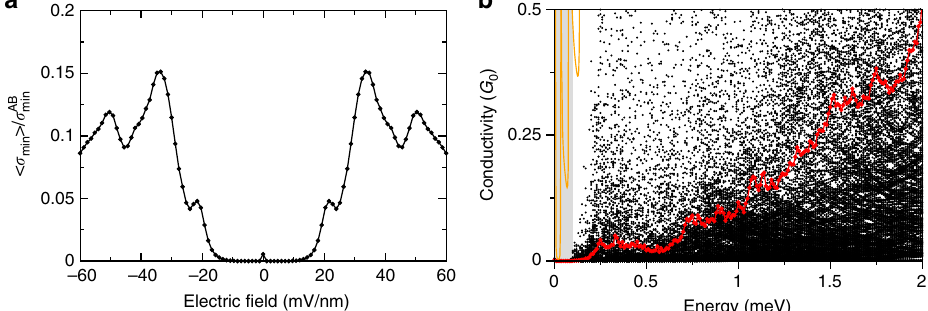
Fig. 5 Restoration of the metallic state. Dependence of the partial dislocation induced insulating state on a layer symmetry breaking potential V and b the Fermi energy E F . In both panels the conductivities are obtained by averaging over a large ensemble of partial con fi gurations that, for zero fi eld and at charge < 0 : 001, where σ AB neutrality, result in an insulating state (de fi ned by σ min = σ AB represents the minimal metallic conductivity of bilayer graphene). In b the min min individual points represent members of the ensemble of conductivities, while the red line denotes the ensemble average. The orange line in b is the conductivity of a perfect dislocation free bilayer, seen to be very different from the dislocation threaded ensemble average. The grey shaded region indicates the energy window within which transport is blocked for all partial con fi